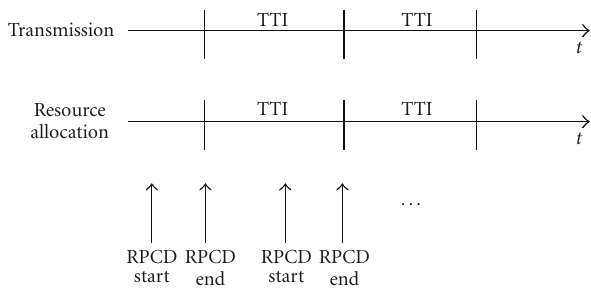
Figure 2: Time Alignment of RPCD with respect to